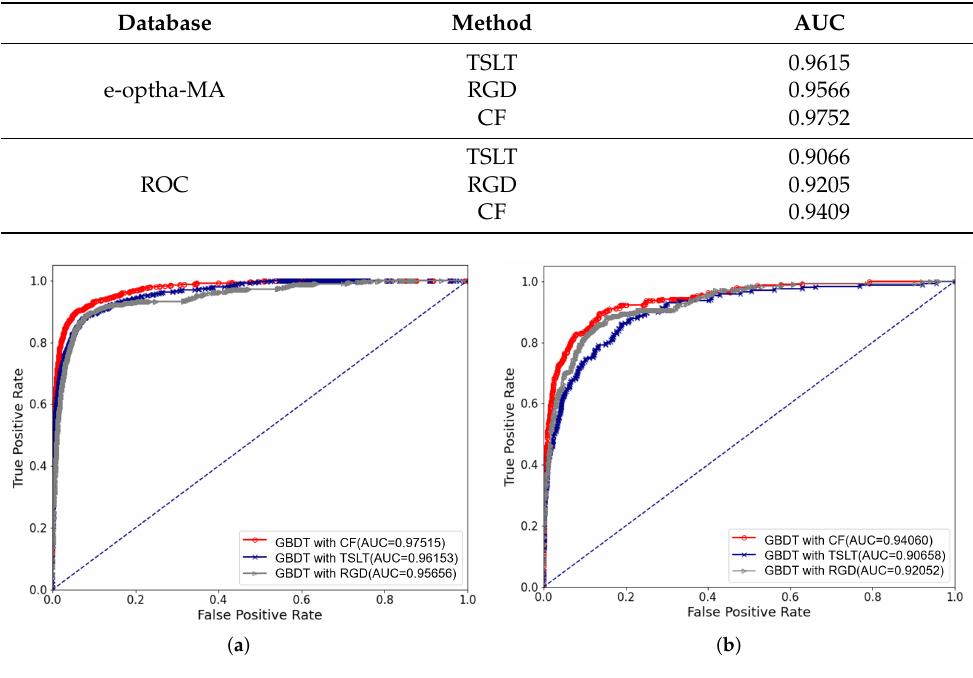
Figure 8. ROC curves of MAs and non-MAs classification on different features. ( a ) The results of the e-optha-MA dataset. ( b ) The results of the ROC